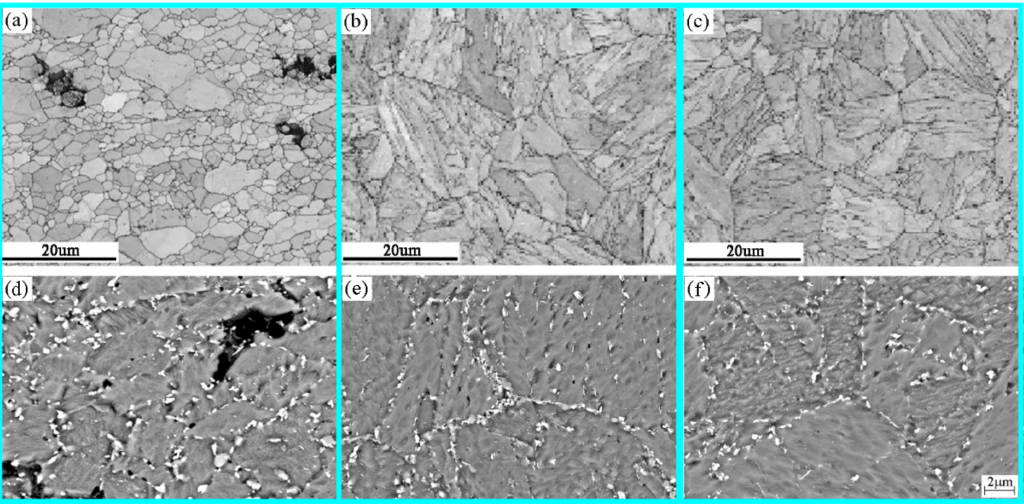
Figure 6. Microstructures at different positions under 100 MPa stress: ( a ) EBSD in near the fracture; ( b ) EBSD in BM; ( c ) EBSD in TE; ( d ) BSE in near the fracture; ( e ) BSE in BM; ( f ) BSE in TE.